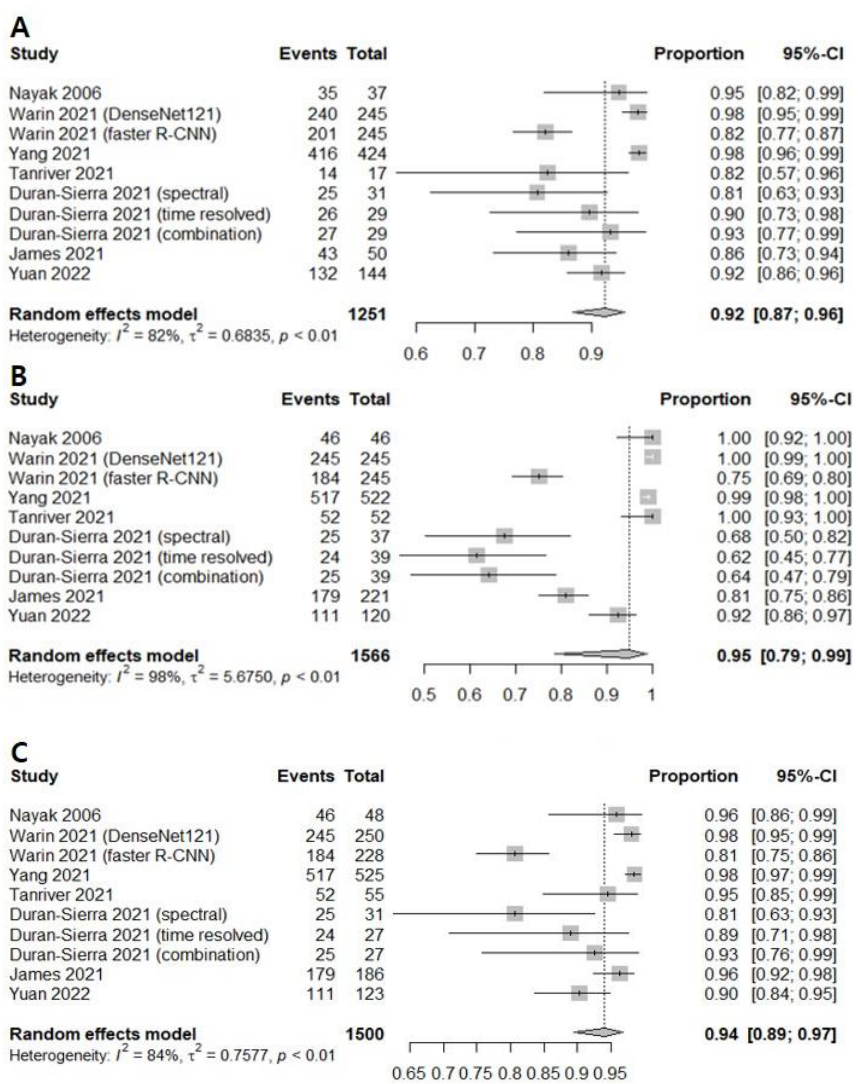
Figure 4. Forest plots of ( A ) sensitivity, ( B ) specificity, and ( C ) negative predictive values for screening oral cancerous lesions